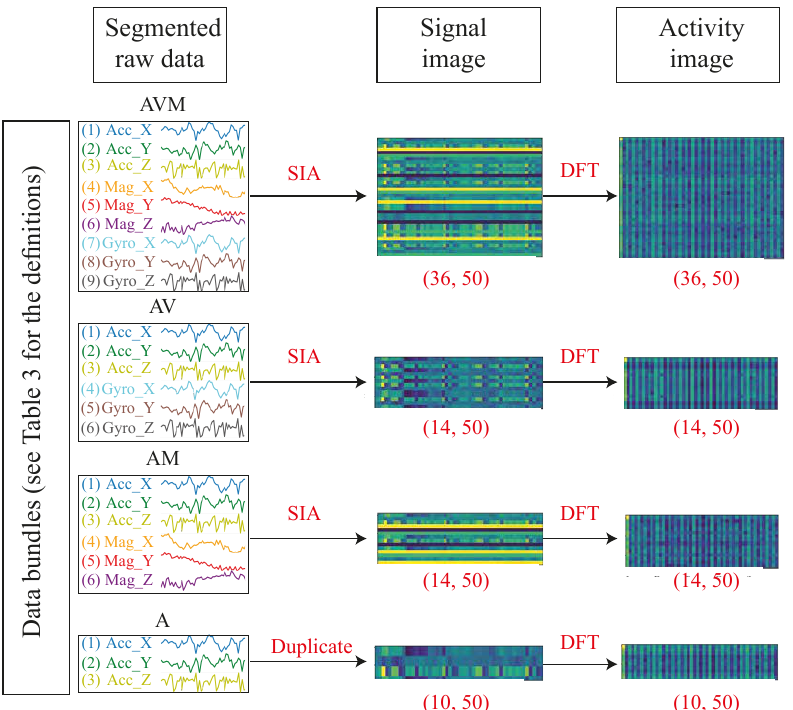
Figure 6. Generation of signal and activity images from the segmented raw data for different data bundles. The channels of the segmented signals are stacked in the signal images row-by-row in the following orders: “123456789135792468147158259369483726” for AVM data bundle,